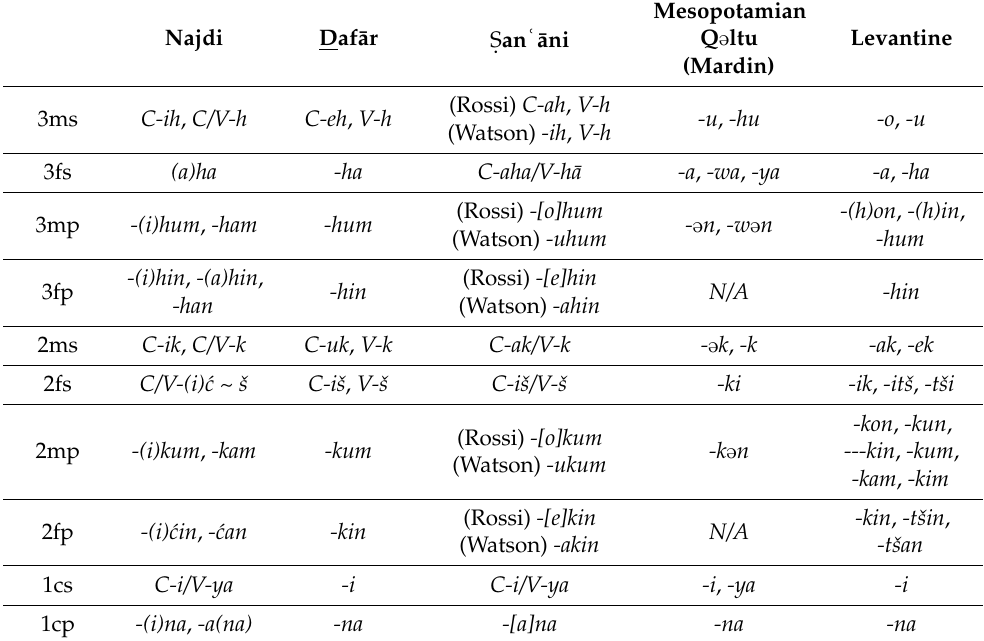
Table 3. Pronominal Suffixes from Sample Arabic